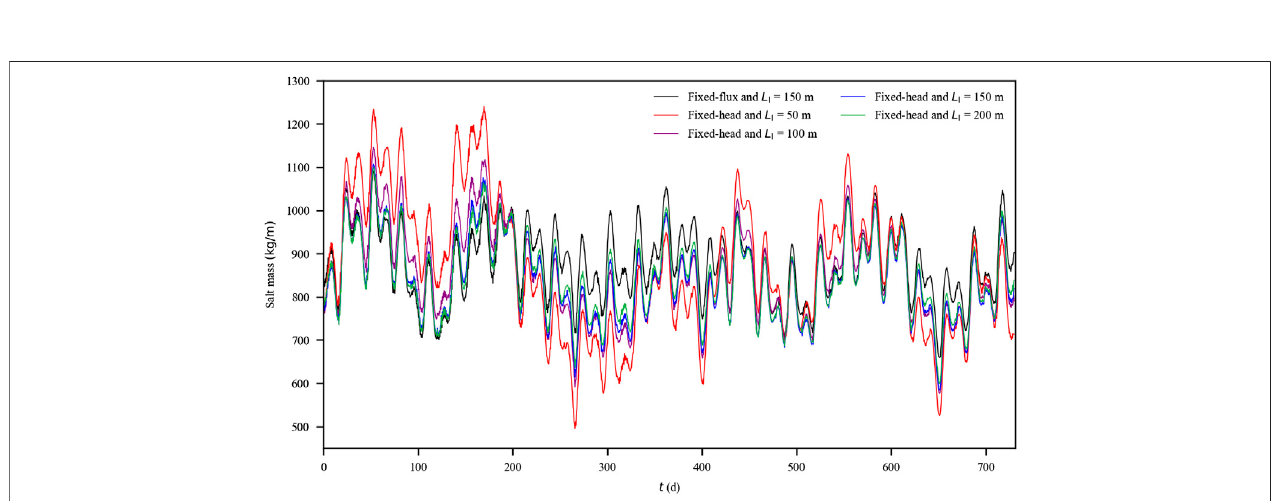
FIGURE6| Averagedamountofsaltstoredintheuppersalineplumeevery12.42 hforthecaseswith fi xed- fl ux( L I (cid:1) 150 m)and fi xed-head( L I (cid:1) 50,100,150,and 200 m) inland boundaries.